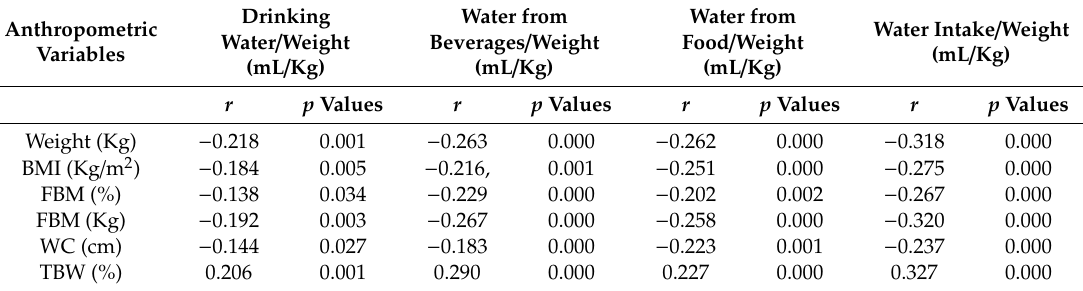
Table 4. Correlation between water intake normalized by body weight from all the sources analyzed with anthropometric and body composition variables of